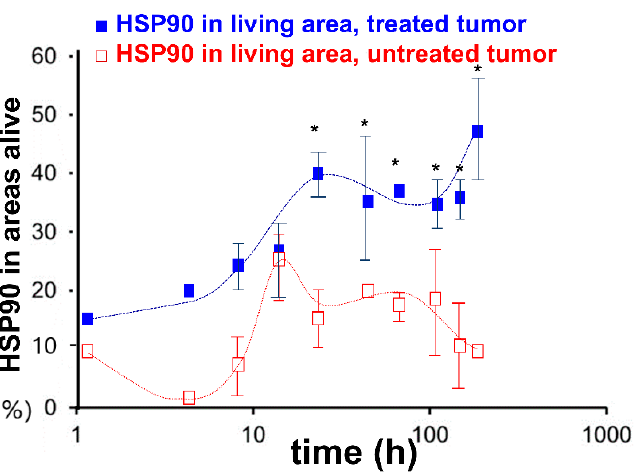
Figure 10. Graph showing the significant increase in HSP90 in the relative mask area (rMA—calculated by dividing the stained area by the whole annotation area), seen between 24 and 216 h posttreatment in the treated tumor cells (solid square markers) compared to the untreated tumor cells (empty square markers) in the morphologically intact areas from excised murine-model tumors (* p < 0.05) [101].